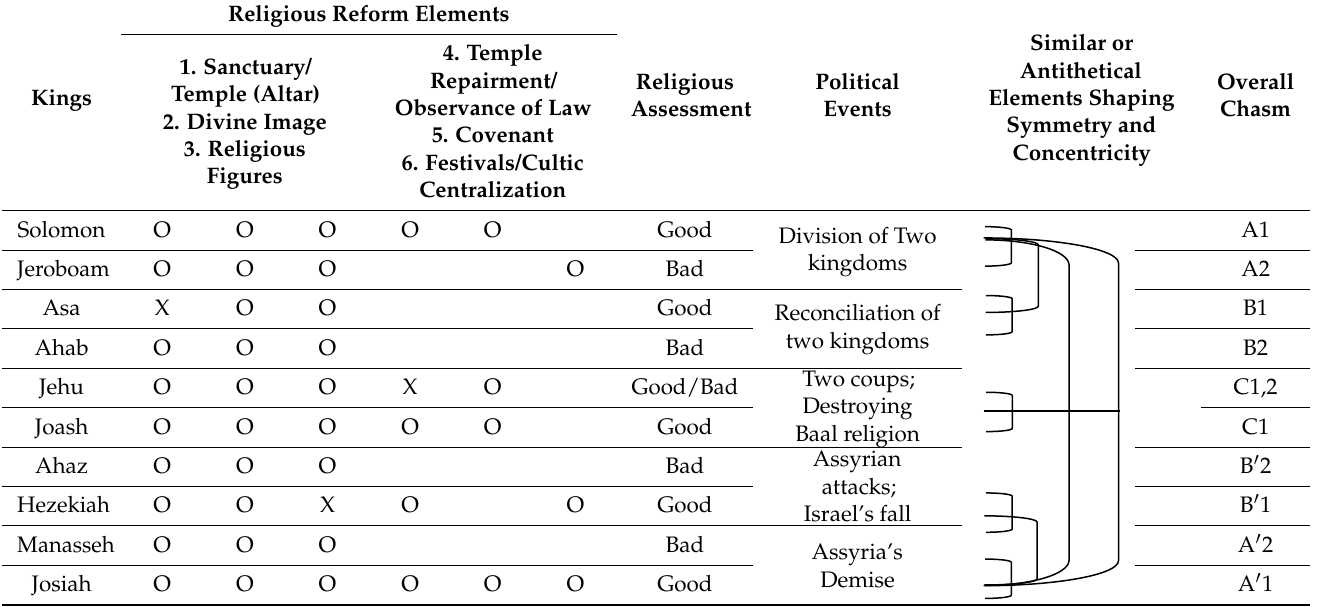
Table 4. Religious reform elements.